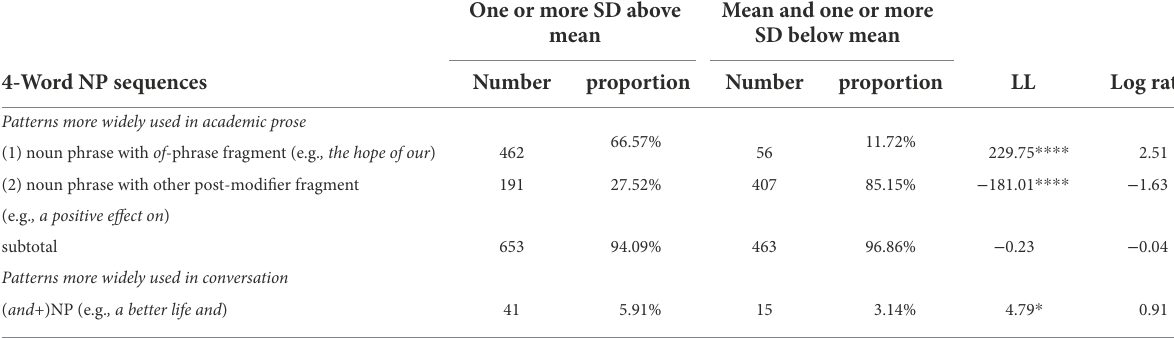
TABLE 9 Distribution of structural patterns of NP sequences in different MI levels.